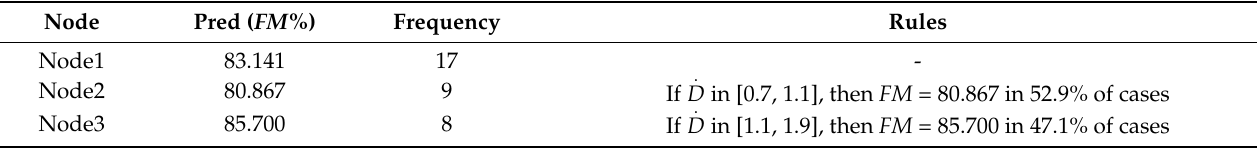
Table 15. Comparison between MLR and PCR models’ accuracy in the prediction of TSS , COD , and FM